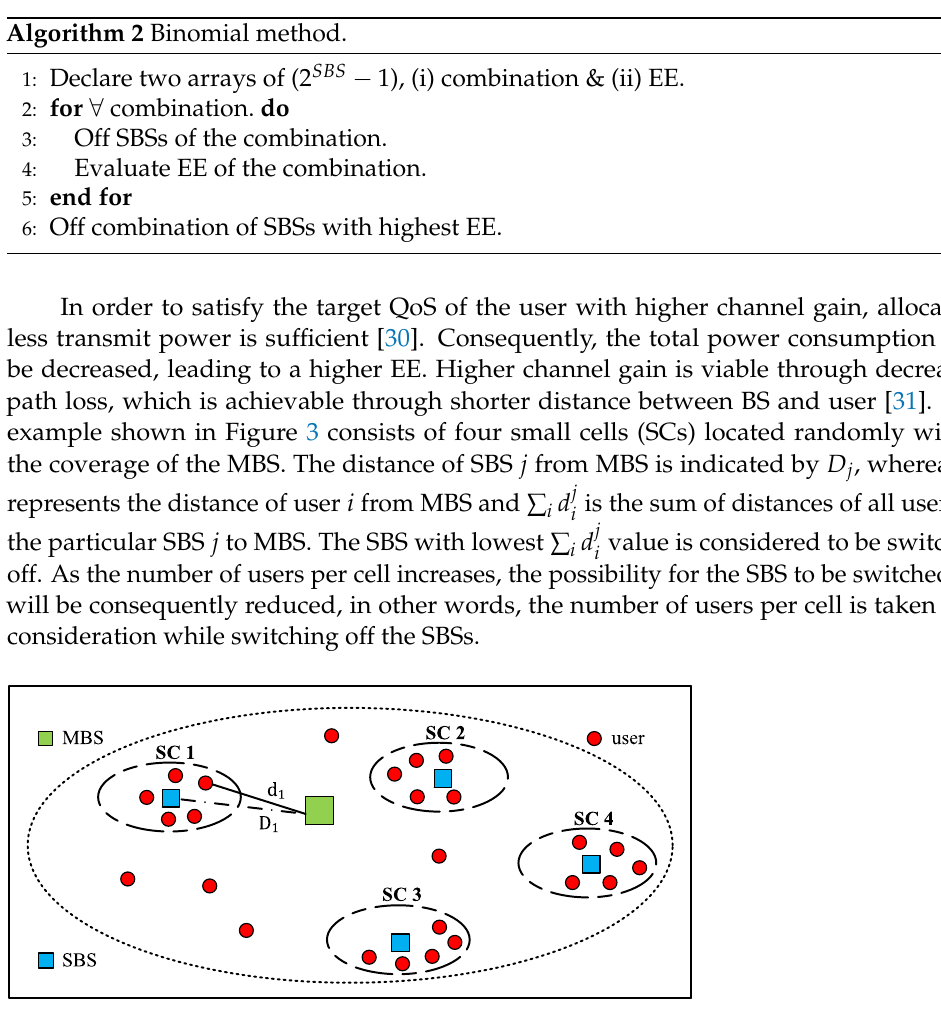
Figure 3. Example of system model consisting of four randomly distributed SBSs and